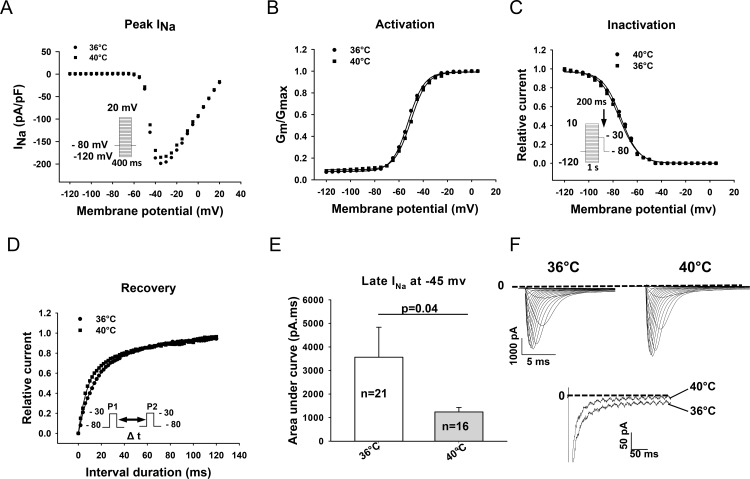
Effects of temperature variation on sodium channel currents and current kinetics.(A) Representative current-voltage relationships for peak INa acquired with indicated voltage protocols (the inset on the left) at 36°C and 40°C. (B) Normalized membrane conductance (Gm/Gmax) versus membrane potentials demonstrating the steady-state activation of INa measured at 36°C and 40°C. (C) Normalized peak INa (Im/Imax) measured at -30 mV with the indicated protocol (inset) versus membrane potentials demonstrating the steady-state inactivation of INa measured at 36°C and 40°C. (D) Recovery of INa from inactivation measured with the indicated protocol (inset) at 36°C and 40°C. (E) Late INa illustrated as the area under the current curve (pA*ms) between 50 and 350 ms of the pulse at -45 mV. (F) Examples of Na+ current traces showing the peak INa and late INa (at -40 mV) recorded at 36°C and 40°C. Values given are mean ± SEM. n, number of cells. ns, P>0.05.